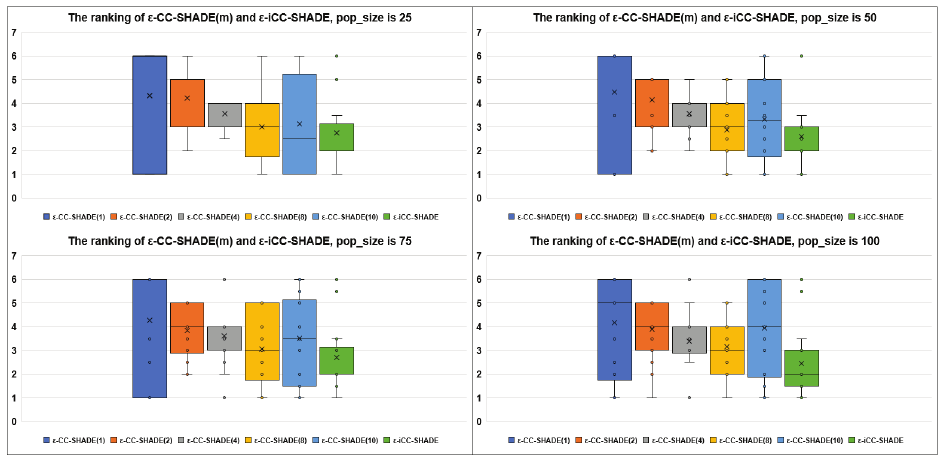
Figure 1. The ranking of ε -CC-SHADE (m) and ε -iCC-SHADE on all problems. Figure 1. The ranking of (cid:905) -CC-SHADE (m) and (cid:905) -iCC-SHADE on all problems. Figure 1. The ranking of (cid:905) -CC-SHADE (m) and (cid:905) -iCC-SHADE on all problems.